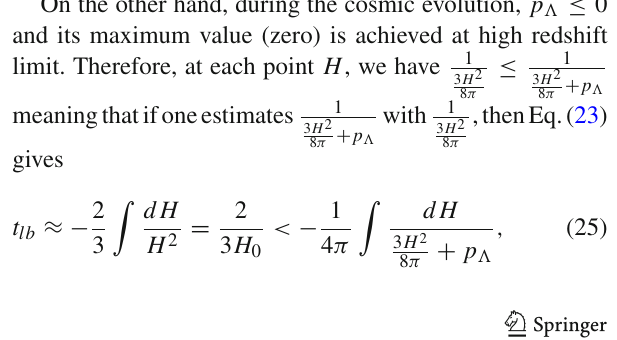
proximity of the curves corresponding on other values of δ to each other, a property also seen in the case of